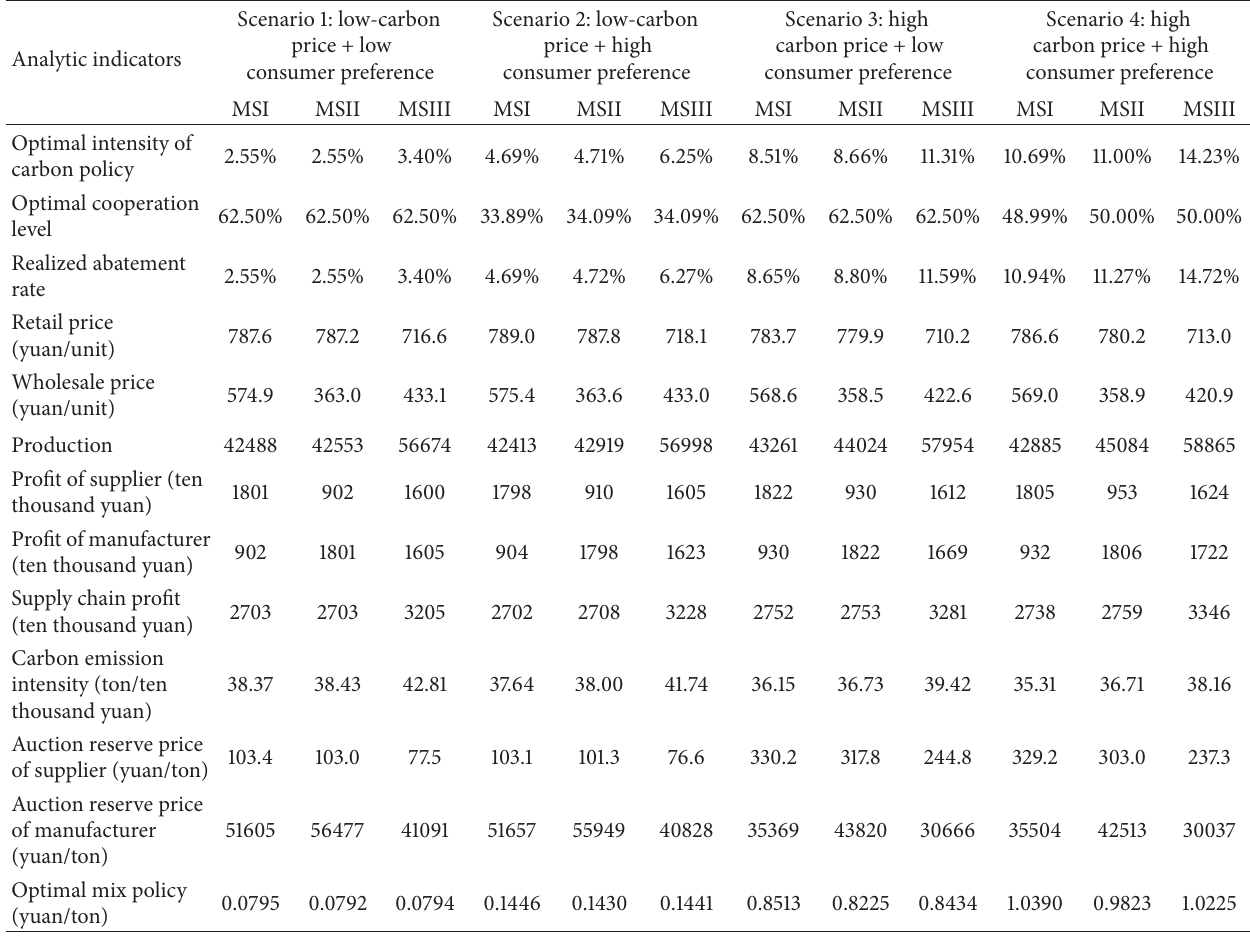
Table 1: Optimal solution for three supply chain abatement modes with current carbon